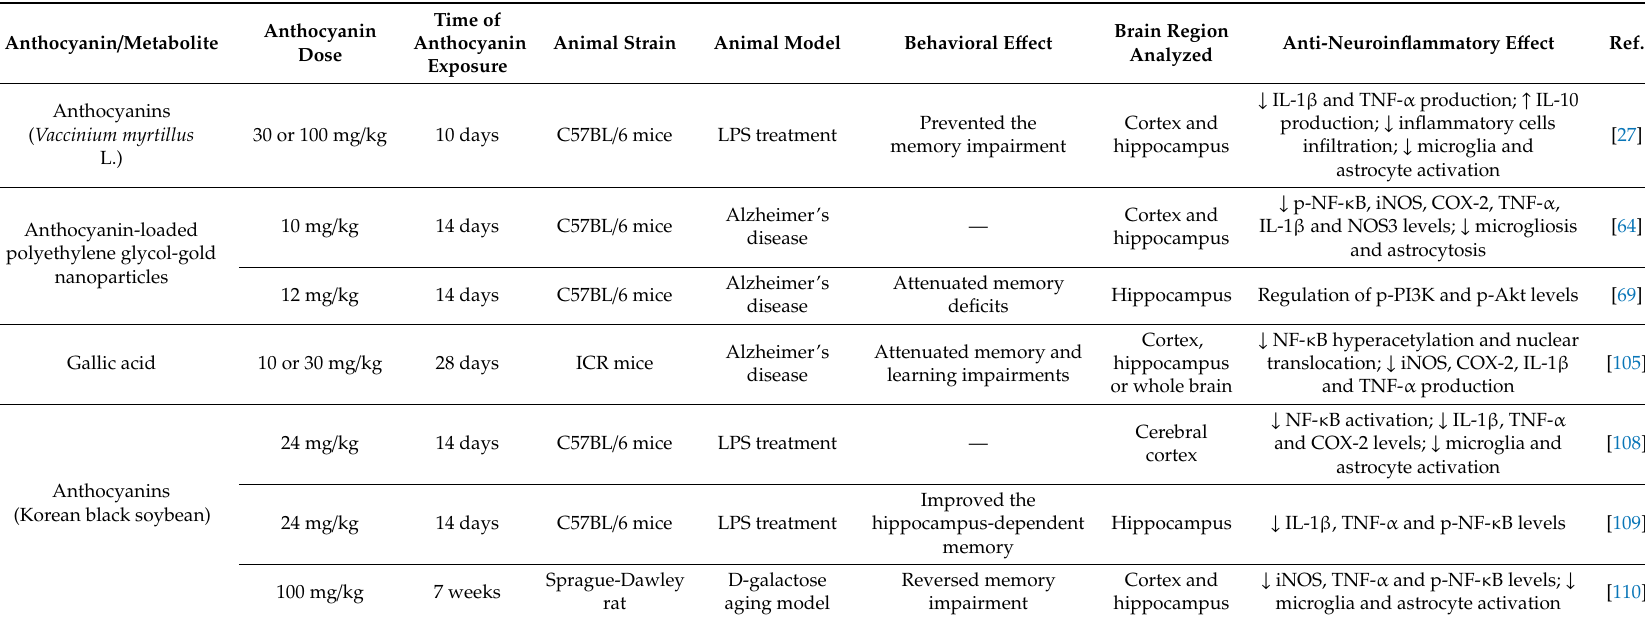
Table 2. Summary of the in vivo studies showing the anti-neuroinflammatory role of anthocyanins and their metabolites. I − = inhibition; ↓ = reduction; ↑ = increase; — = not